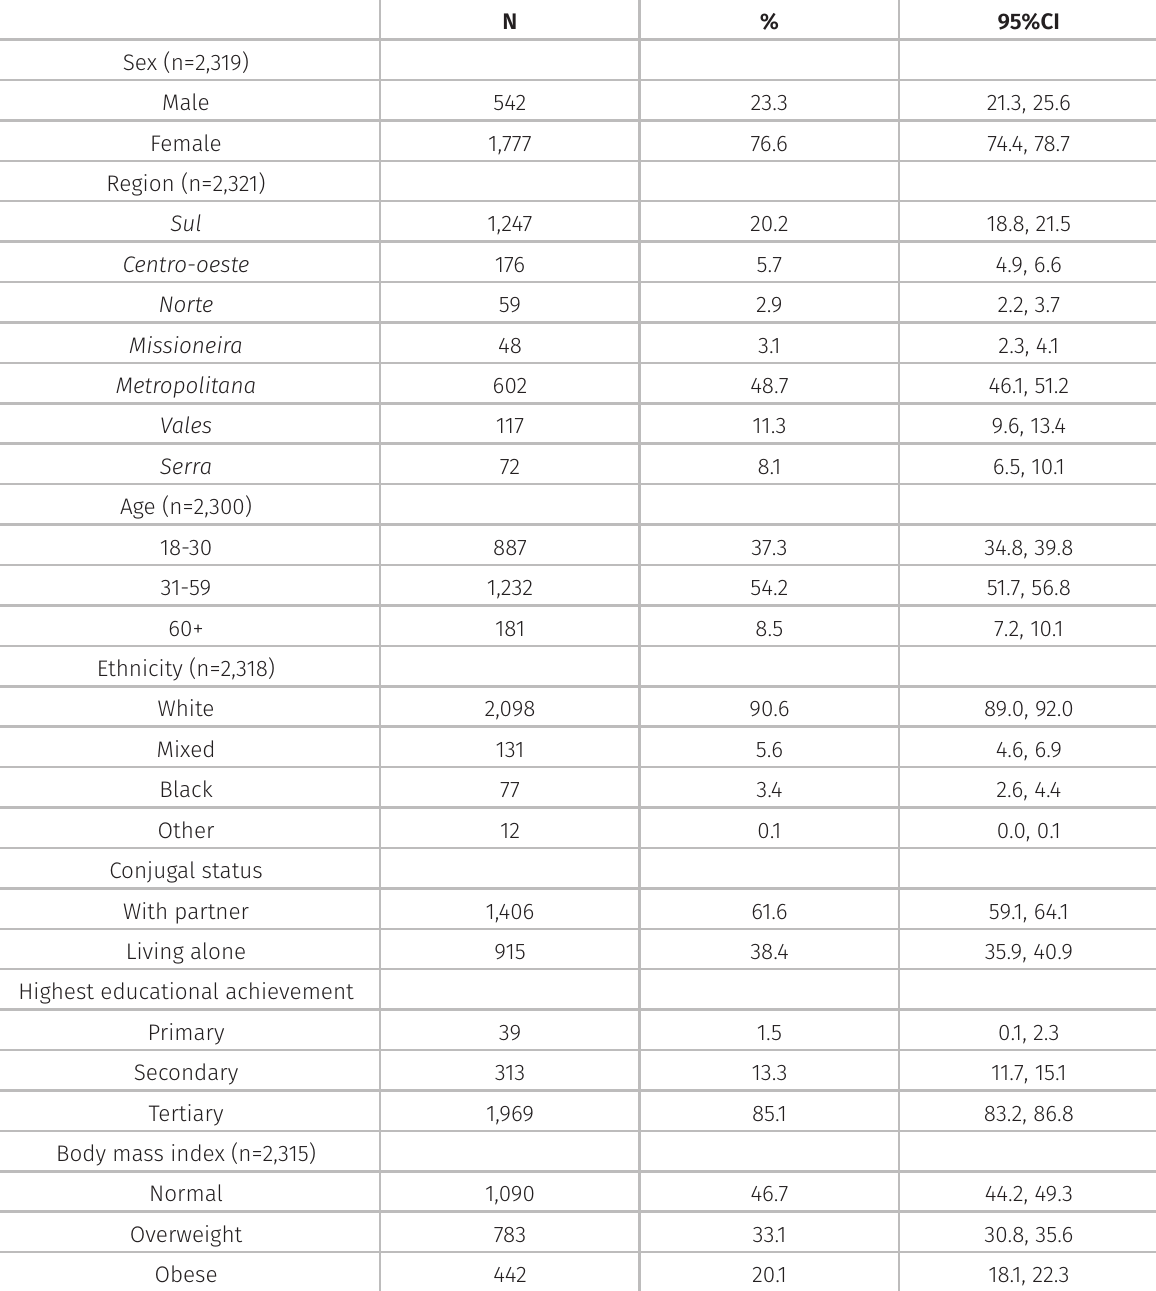
Table I. Sociodemographic and nutritional characteristics of the included participants. Rio Grande do Sul, Brazil. N=2,321. CI: confidence